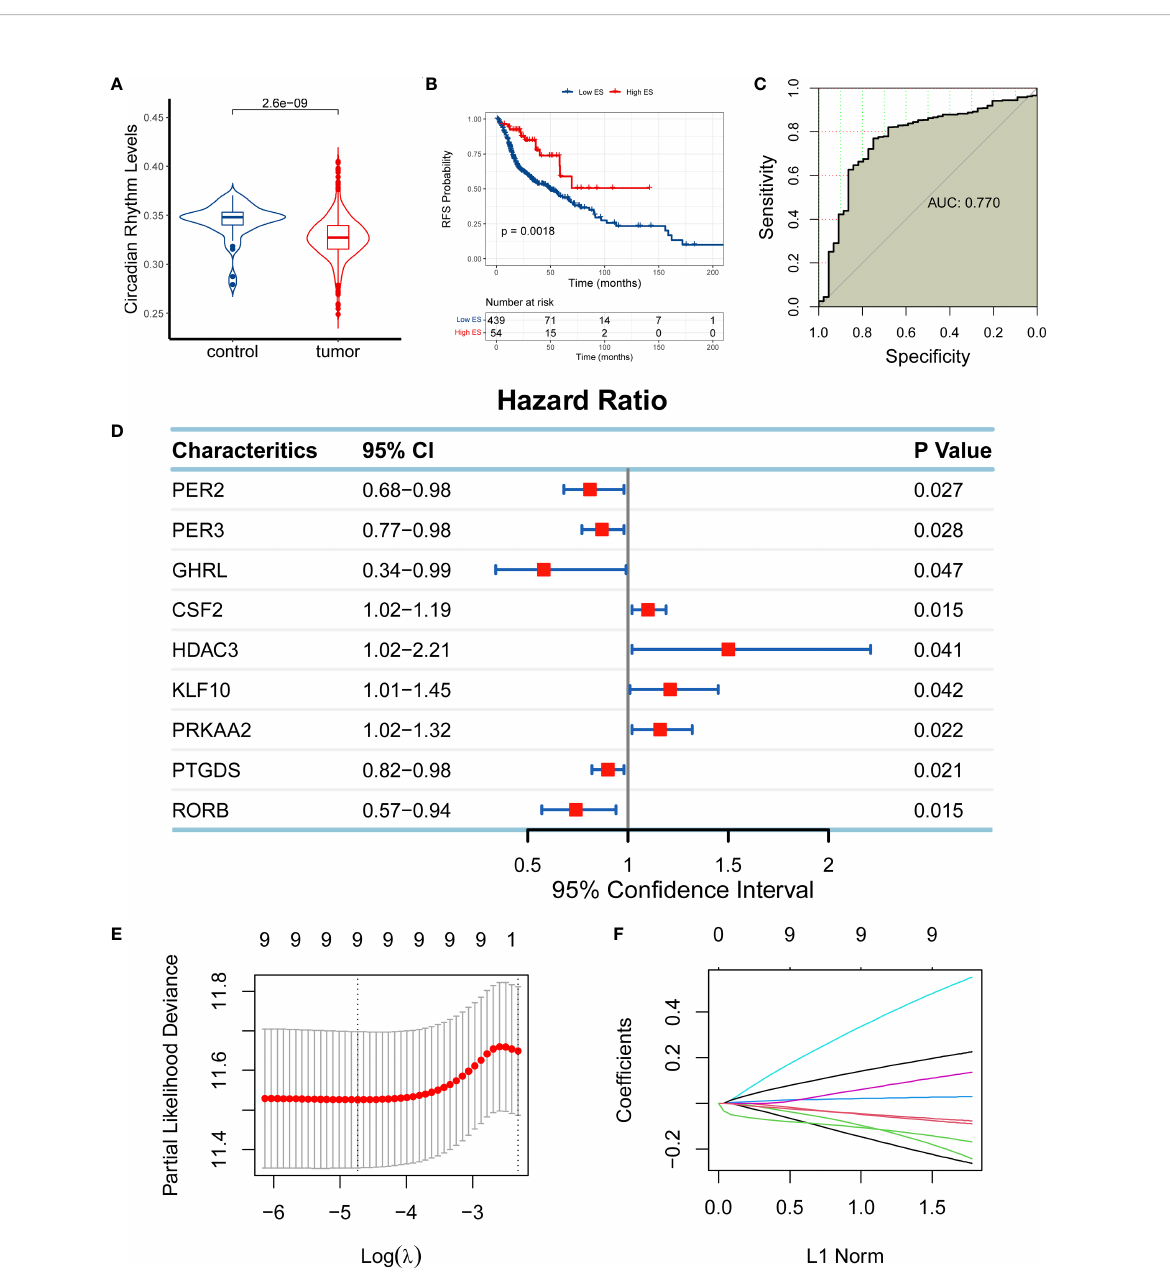
of a CR-related gene signature for predicting OS in HNSC patients (Figures 1E, F). The CR-related gene signature was quanti fi ed based on the mRNA expression levels and the corresponding